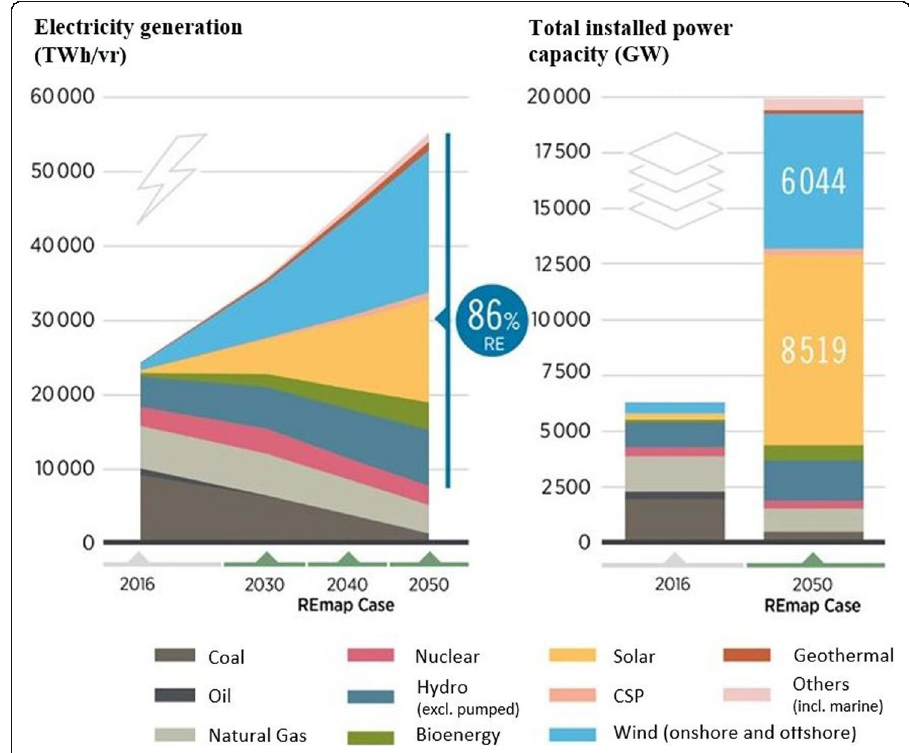
Fig. 1 Share of the different sources of energy in the global electricity generation (left) and installed power (right) starting from 2016 up to 2050